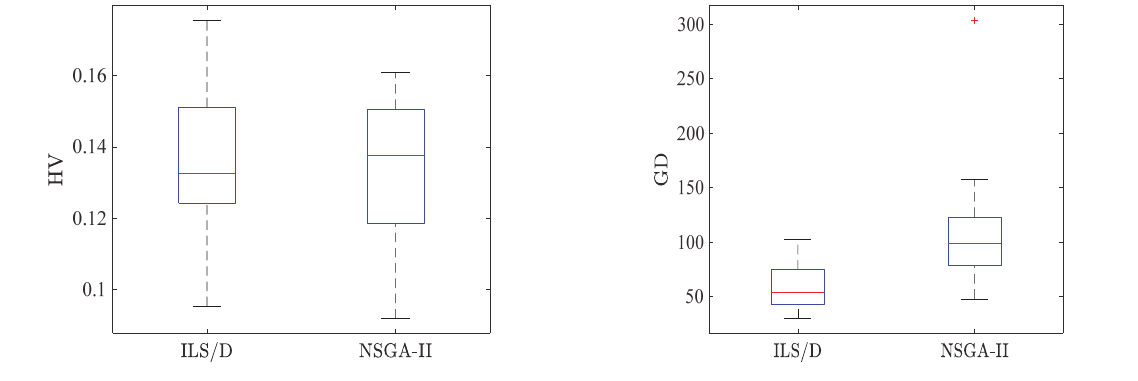
Fig.7 . The HV boxplot for both the ILS/D and NSGA- II algorithms for instance A-n80-k10